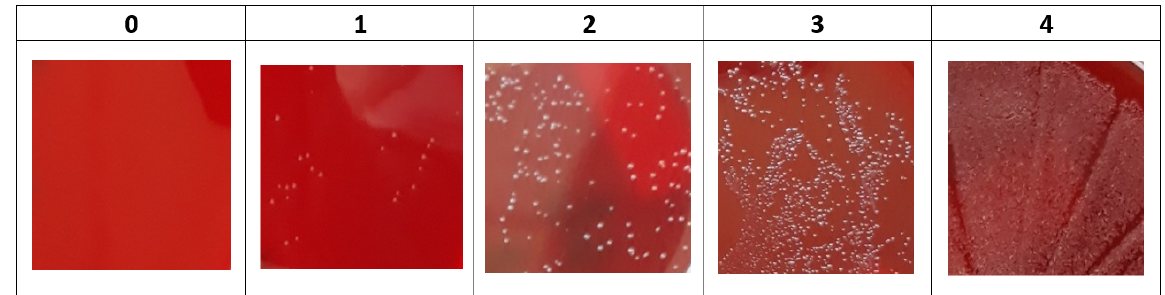
Figure 1. Five-point scale for scoring Neisseria gonorrhoeae growth on blood agar (0 = no growth; 1 = some colonies; 2 = numerous colonies; 3 = entire agar plate covered with colonies; 4 = confluent growth of